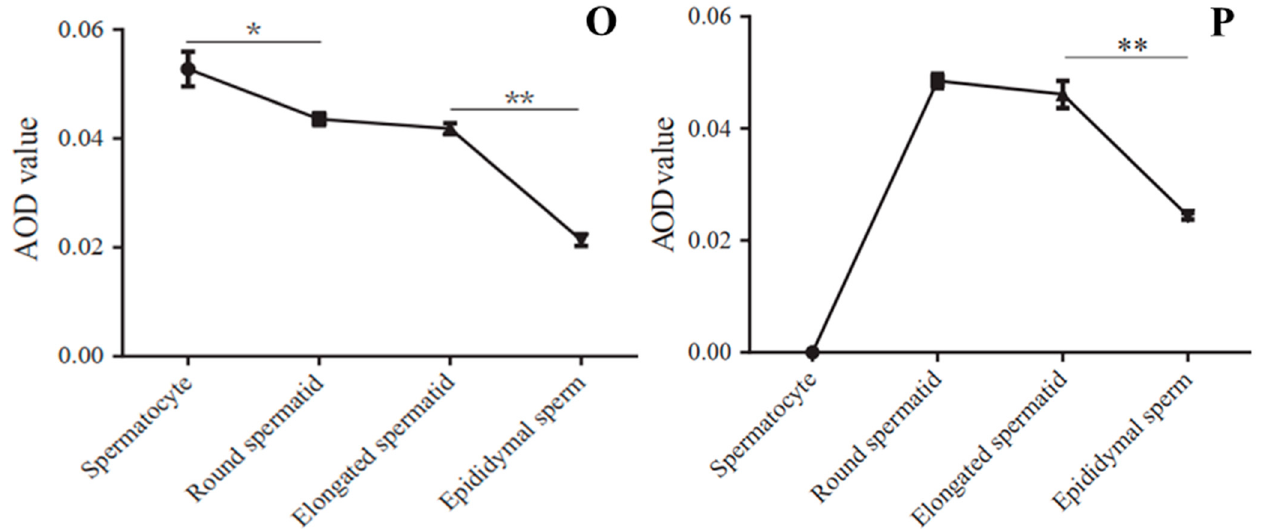
Figure 7. ART3 immunofluorescence staining. ( A – C ) Staining results of cross-sections of the seminiferous tubules of mouse testis; ( D – F ) staining results of cross-sections of the seminiferous tubules of bovine testis. ( G – J ) Staining results of mouse epididymal sperm, and ( K – N ) the staining results of bovine epididymal sperm. Blue represents the nucleus stained by DAPI; red represents the positive signal of the ART3 antibody. ( C , F , I , M ) Merged images of ART3 and nuclear staining. ( J , N ) The microscopic images of epididymal sperm without any staining under the bright field. ( O , P ) The AOD values of ART3 at different stages of spermatid development in bovine and mouse, respectively. The y -axis represents the AOD value, whereas the x -axis represents different cell types. The AOD values were represented as the mean with error bars indicating standard error of the mean (mean ± SEM). Student’s t -test was used to assess the statistical significance (* p < 0.05, ** p < 0.01). ( A – F ): ×200 magnification; scale bar = 100 μ m. ( G – N ): ×1000 magnification; scale bar = 10 μ m.